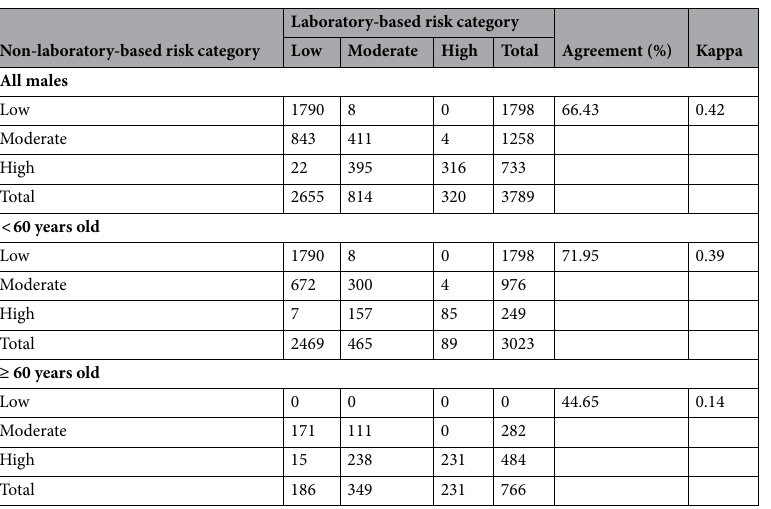
Table 2. Agreement between the laboratory-based and non-laboratory-based risk scores according to the grouped risk in males.